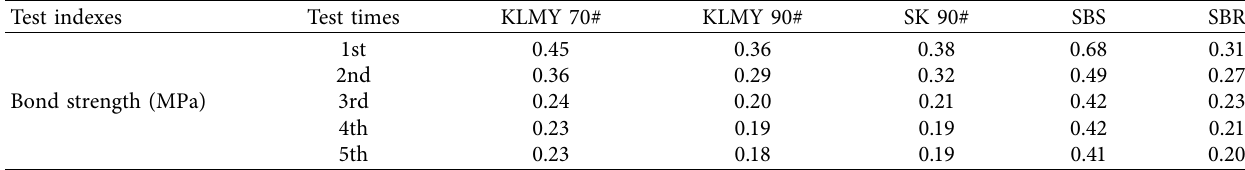
Table 11: Bond strength of each adhesion failure.